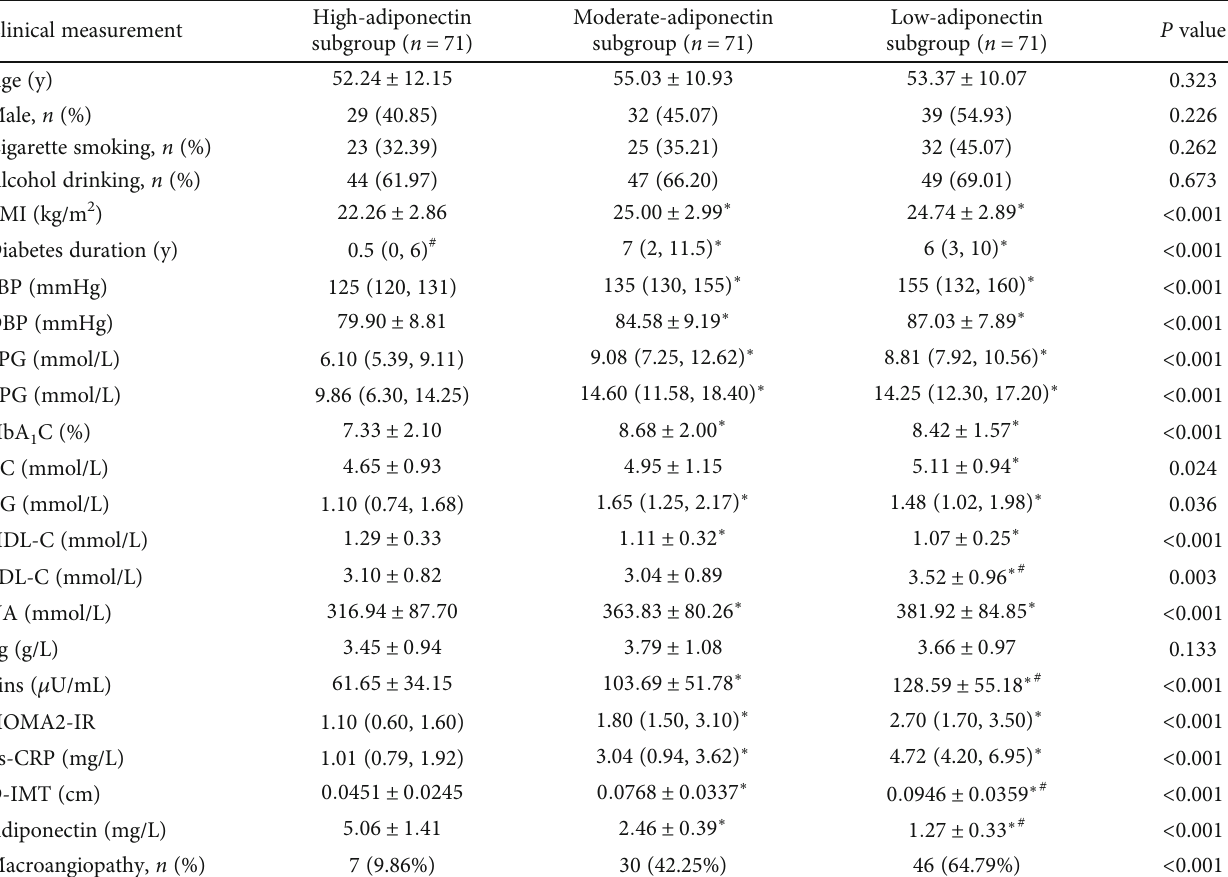
Table 3: Clinical characteristics among the di ff erent